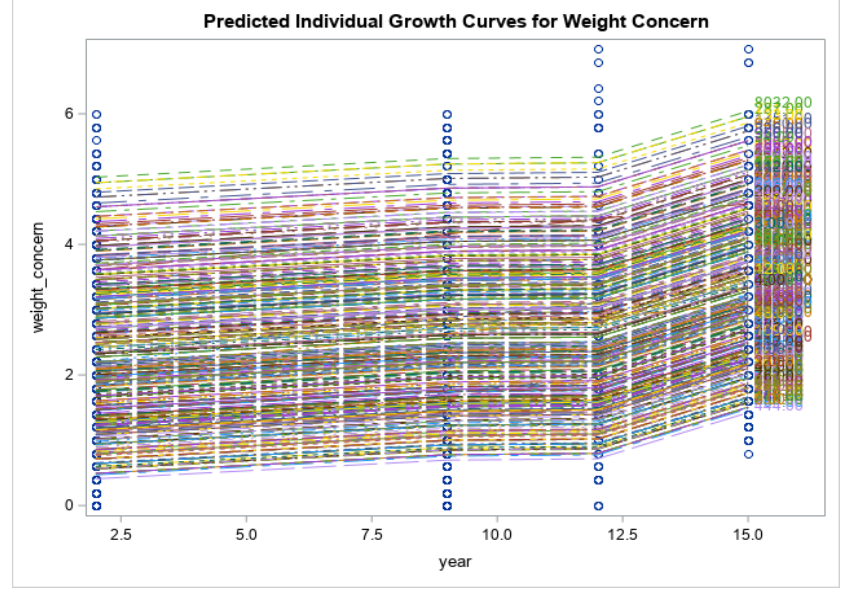
Figure 1. Predicted individual growth curves for weight concern. The blue lines indicate the measurement time points.